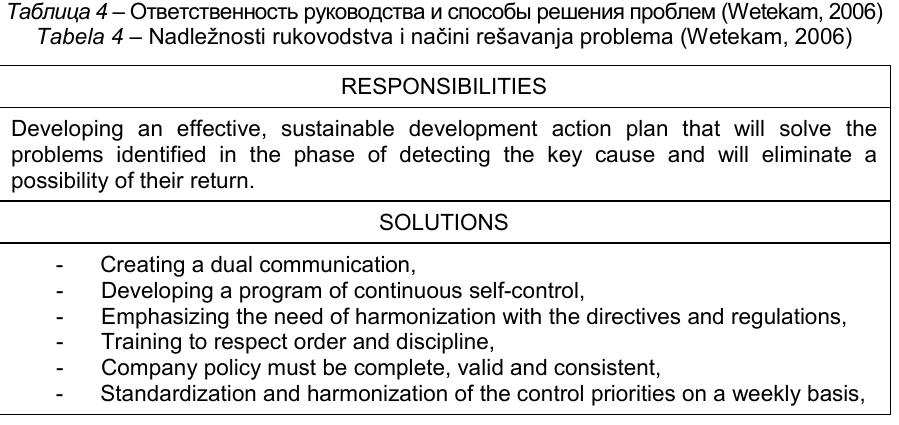
Table 4 – Responsibilities of the management and the problem solving